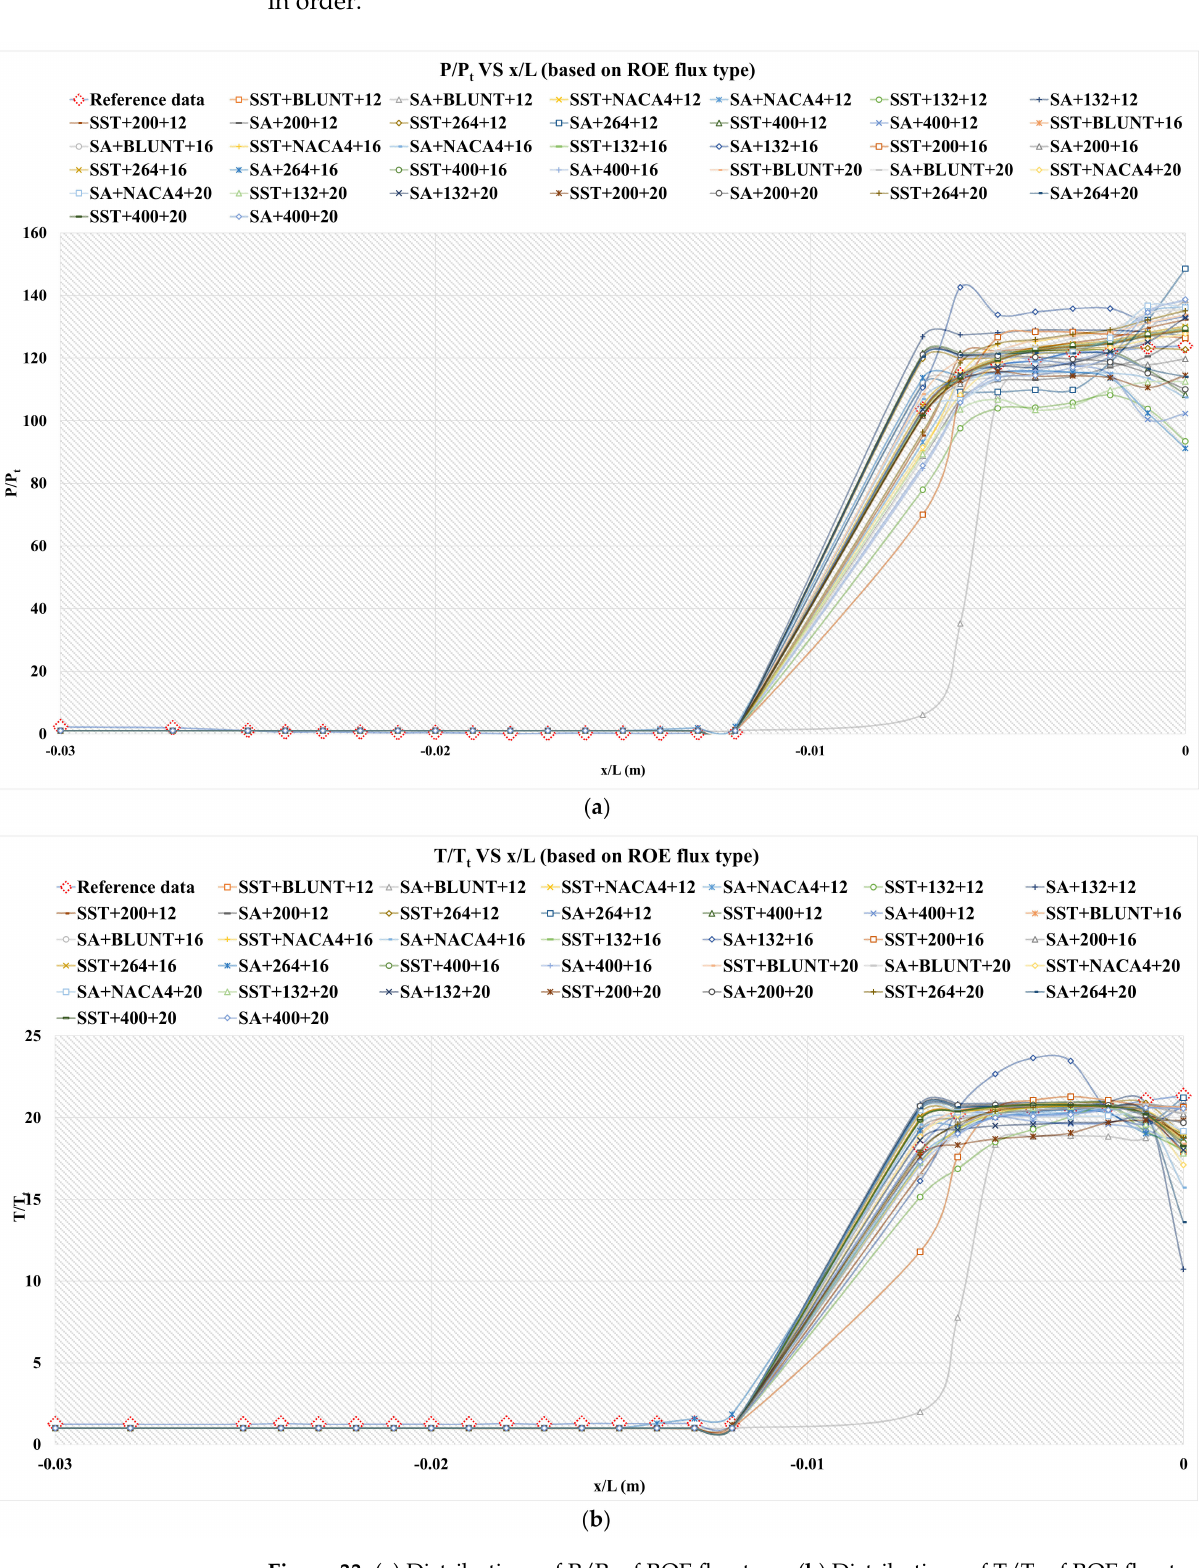
Figure 33. ( a ) Distributions of P/P t of ROE flux type; ( b ) Distributions of T/T t of ROE flux